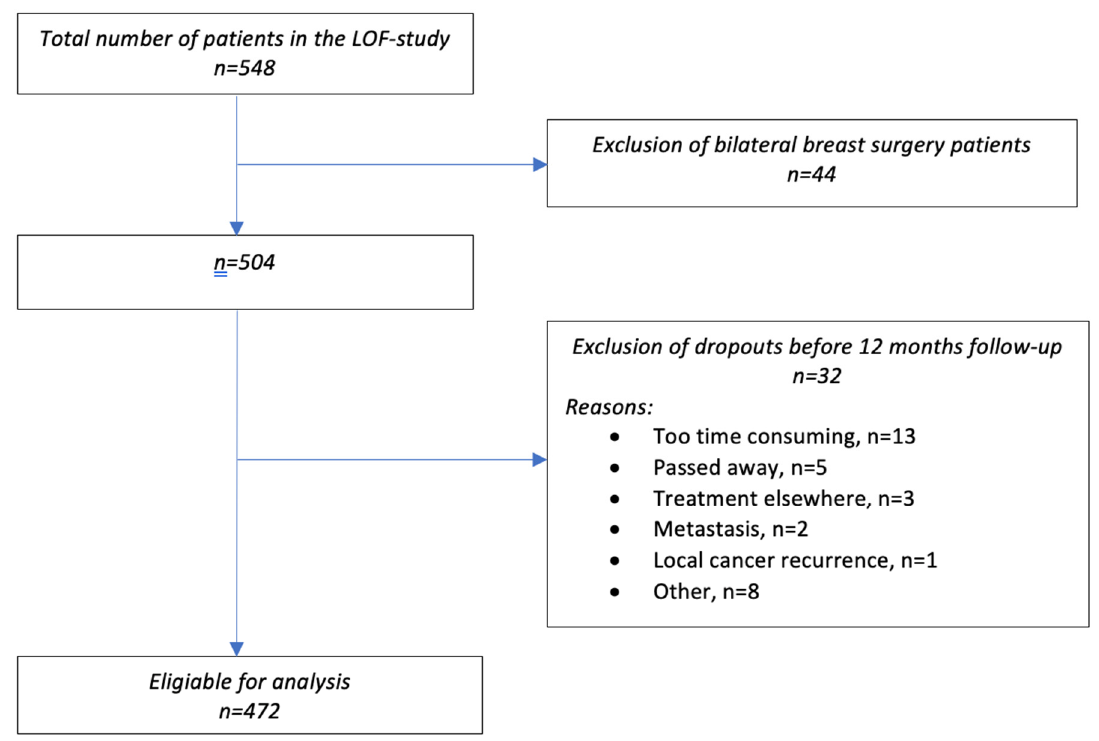
Figure 1. Flow diagram of eligible patients and those ultimately included in the analysis.